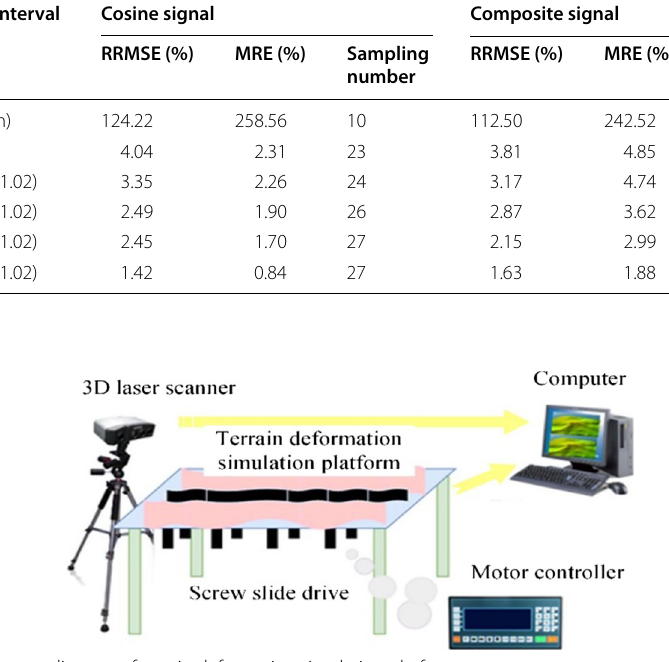
Fig. 9 Structure diagram of terrain deformation simulation platform